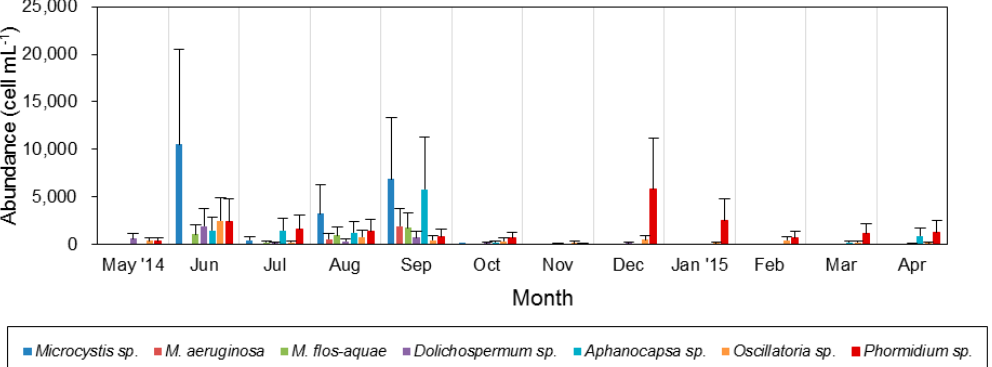
Figure 7. Variation in temporal abundance of the potentially toxic species in the upper regions of the Youngsan River estuary.